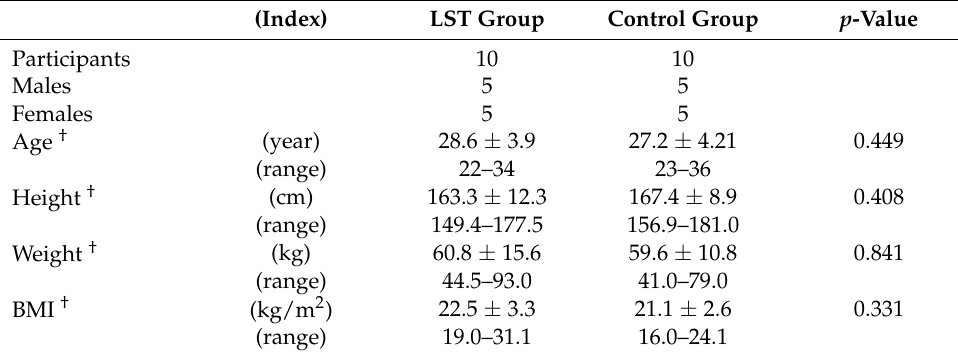
Table 1. Descriptive characteristics of the participants in the LST and control groups.